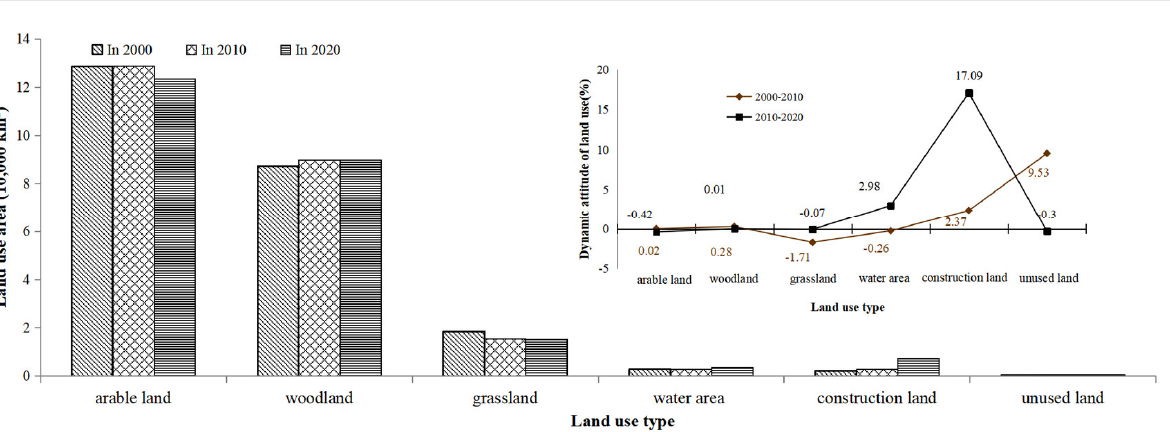
Figure 5. Areas of land use types in 2000, 2010, and 2020 and the dynamic degree of land use from 2000 to 2020.